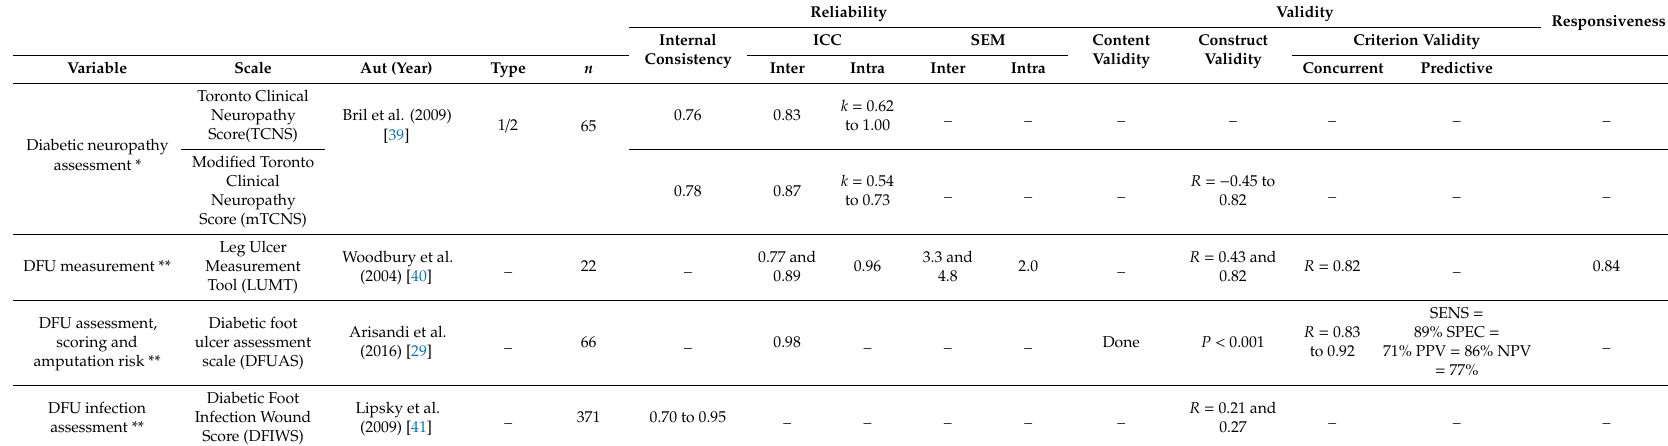
Table 3. Clinician assessment tools validated for the assessment of DFD and DFU related variables according to consensus-based standards for the selection of health measurement instruments (COSMIN)